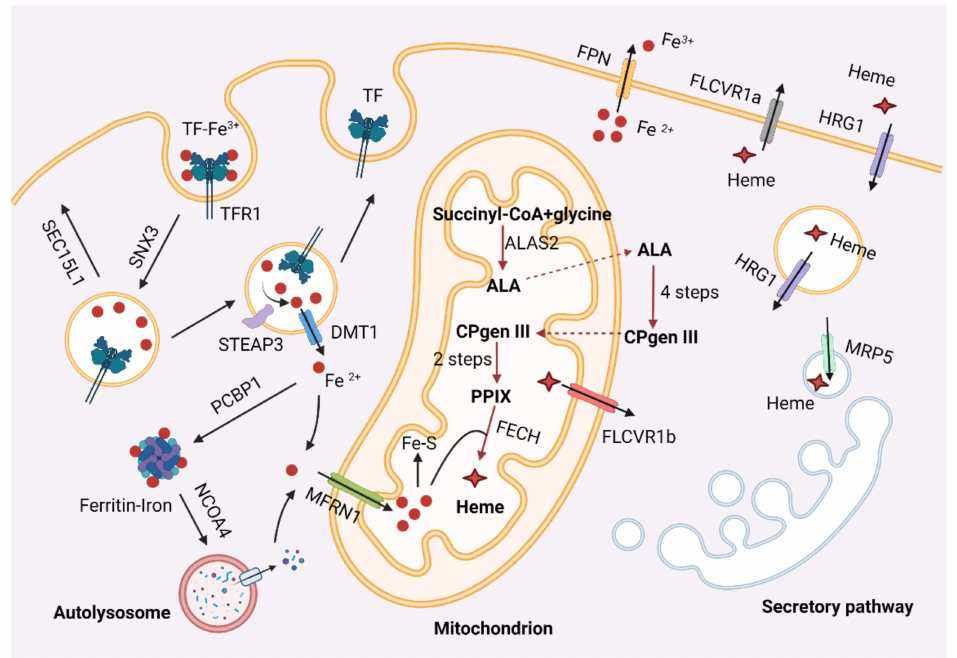
Figure 2. Iron and heme metabolism during erythropoiesis. Iron metabolism is shown on the left. Heme biosynthesis is shown in the middle. Heme trafficking is shown on the right. TF, transferrin; MFRN1, mitoferrin 1; DMT1, divalent metal transporter 1; PCBP1, poly r(C)-binding protein; NCOA4, nuclear receptor coactivator 4; FPN, ferroportin; FLVCR1, feline leukemia virus subgroup C receptor-related protein 1; HRG1, heme responsive gene 1; MRP5, multidrug resistance protein 5; FECH, ferrochelatase; ALA, δ -aminolevulinic acid; CPgen III, coproporphyrinogen III; PPIX, protoporphyrin